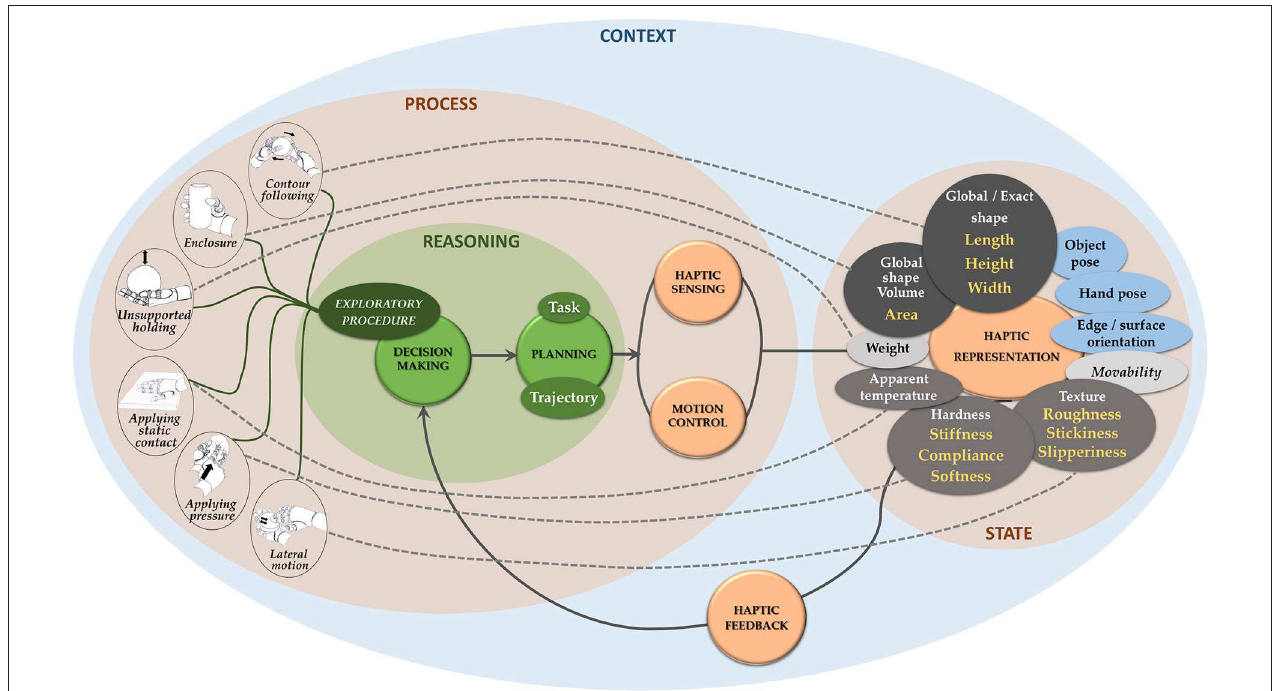
FIGURE 4 | Exploratory procedures associated with haptic features as in Lederman and Klatzky (2009). Pictures on exploratory procedures have been borrowed from Lederman and Klatzky (1987) (with permission from the authors), where the human hand has been replaced with a robotic